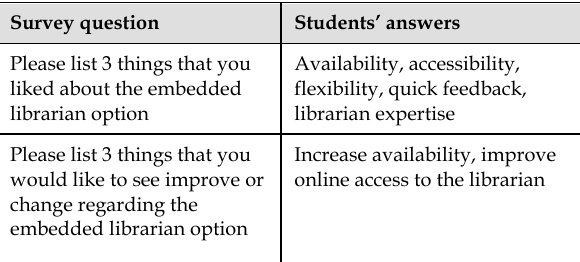
Table 2 Embedded librarian project open-ended questions survey